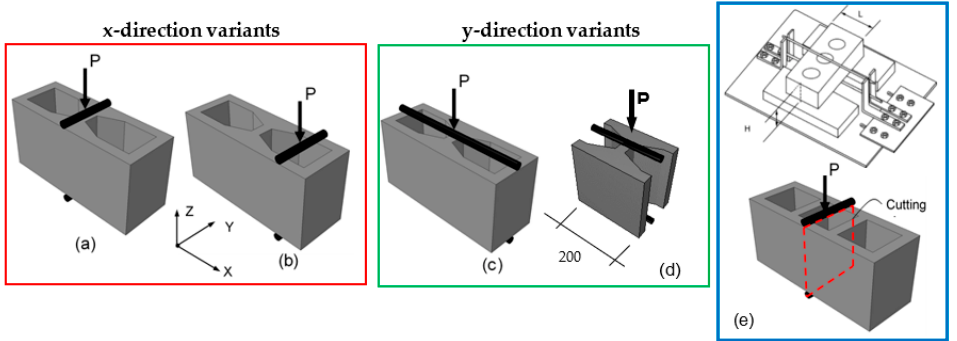
Figure 1. Splitting tests applied to the blocks ( a ) in the x-direction (longitudinal) over the gross area, ( b ) in the x-direction over the net area, ( c ) in the y-direction (transversal), and ( d ) 200 mm from the central region of the block in the y-direction. ( e ) Guidelines of ASTM C-1006-13 [26]. Table 1. Averages values from the compressive